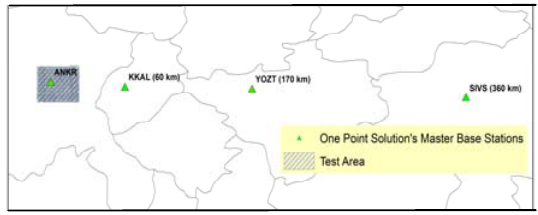
Figure 2. Distribution of single point master stations